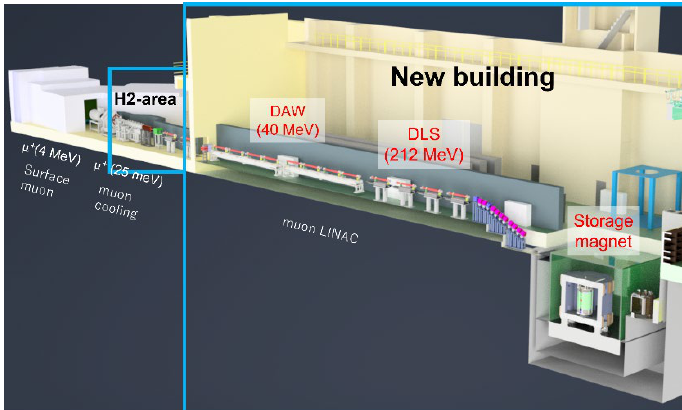
Fig. 6. Extension plan of the